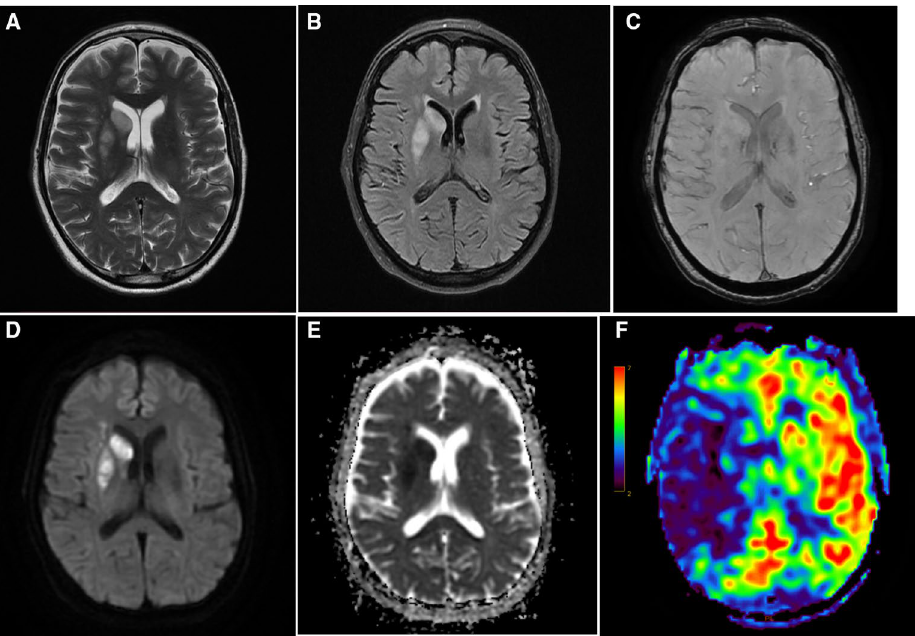
Fig. 2 Acute infarction with ischemic penumbra: 78 years old male patient complaining of left hemiplegia since 8 h. A T2WI, B FLAIR, C SWI, D DWI, and E ADC map show acute ischemic infarct at the right basal ganglia. ASPECTS score was 8/10. F ASL perfusion at 1.5 s shows larger area of hypo perfusion (diffusion perfusion mismatch) reflecting large area of ischemic penumbra, aCBF aCBF absolute cerebral blood flow, ADC apparent diffusion coefficient, ASL arterial spin labeling, ASPECT Alberta Stroke Program Early CT Score, DWI